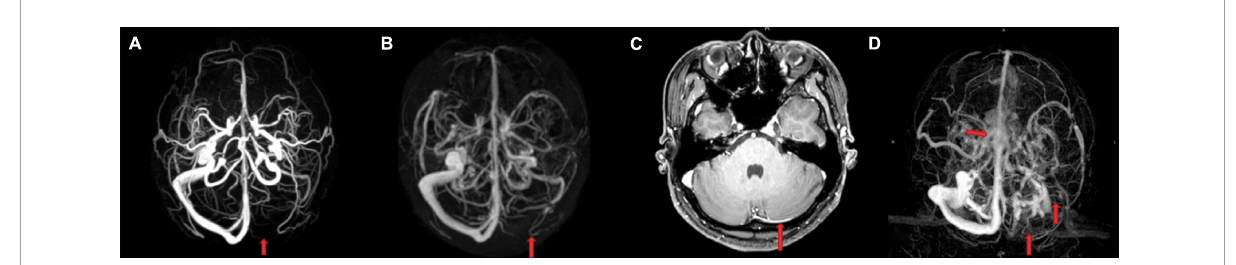
FIGURE1 Comparison of the imaging findings between a 26-year-old healthy woman without cerebral venous system diseases and another clinical history (A–C) and a 26-year-old female cerebral sinus thrombosis patient (D) . (A) Phase-contrast-magnetic resonance venography (MRV) and (B) contrast-enhanced-MRV showed a suspicious aplastic or occlusive left transverse sinus (TS). While enhanced T1 image (C) showed that the left TS was not aplastic but slender. (D) The left TS, sigmoid sinus, and upper internal jugular vein were not visualized because of thrombosis, and the central part of superior sagittal sinus appeared rough and rugged.